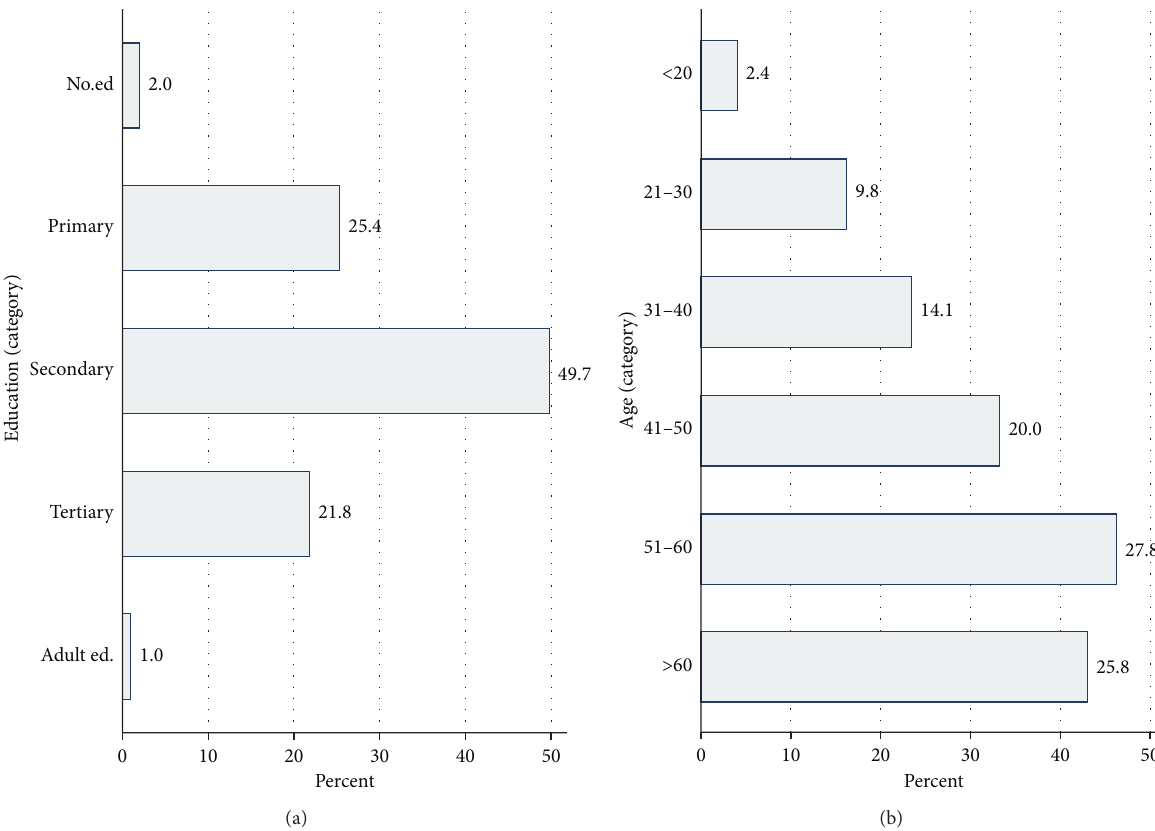
Figure 5: Education level and age distribution among respondents. More than 70% of respondents have secondary/tertiary education and more than 70% are 40 years and older. (a) Education distribution-respondents. (b) Age